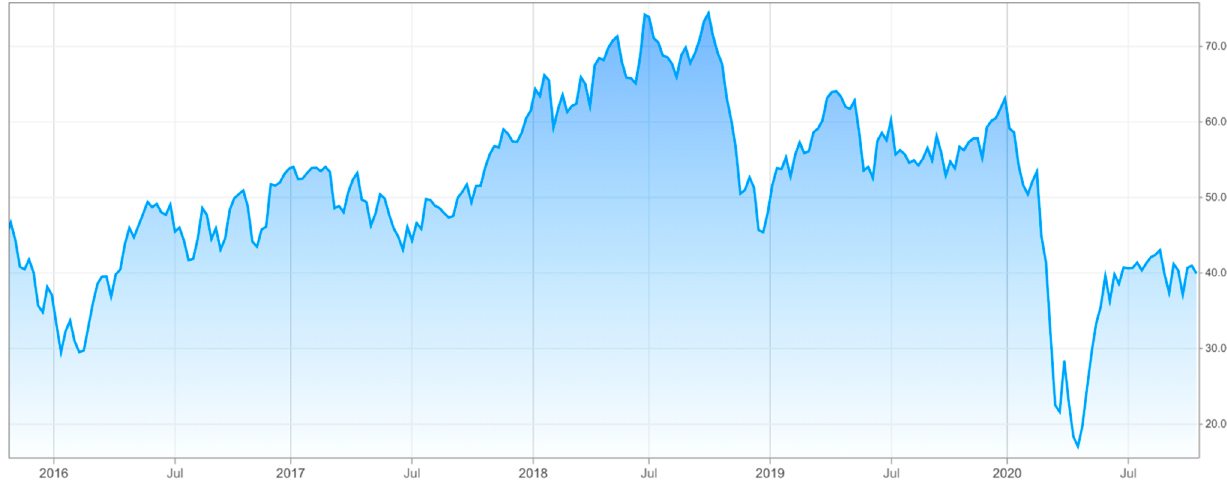
Figure 5. US WTI oil prices fall in first quarter of 2020, CNBC [11].